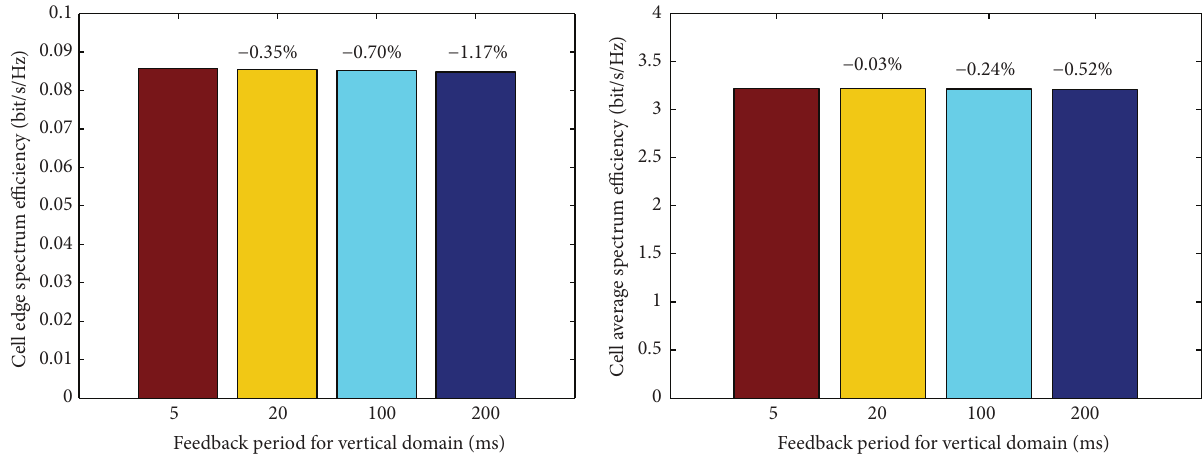
Figure 10: Feedback period for vertical domain with different values in 3D-UMa